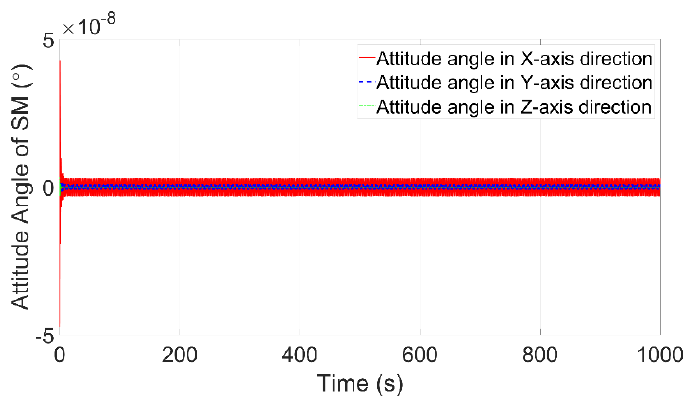
Figure 9. Attitude angle of the SM.